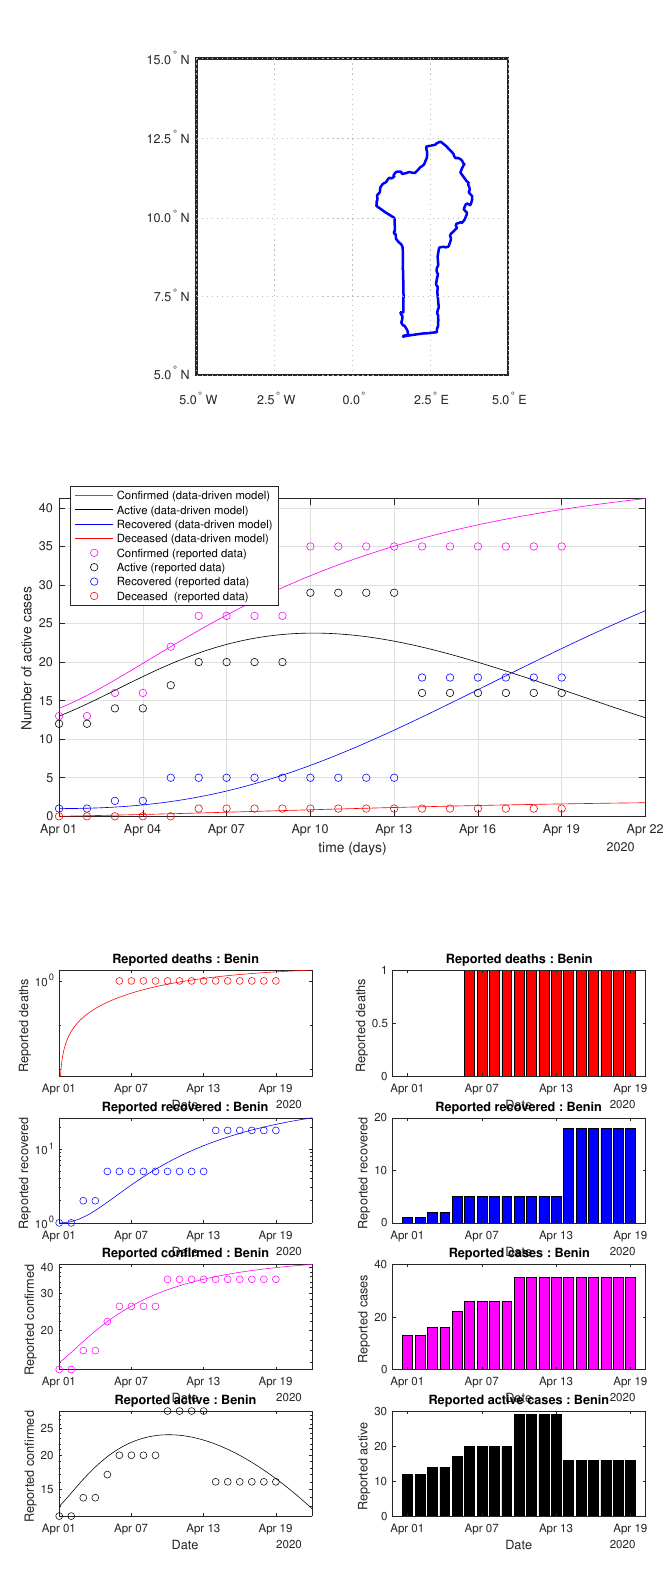
Figure 53. Benin: data of active, recovered, deceased (in circle or bar) vs. model of active, recovered, deceased over time. Tracking the number of active cases. Predictive analytics for the next couple